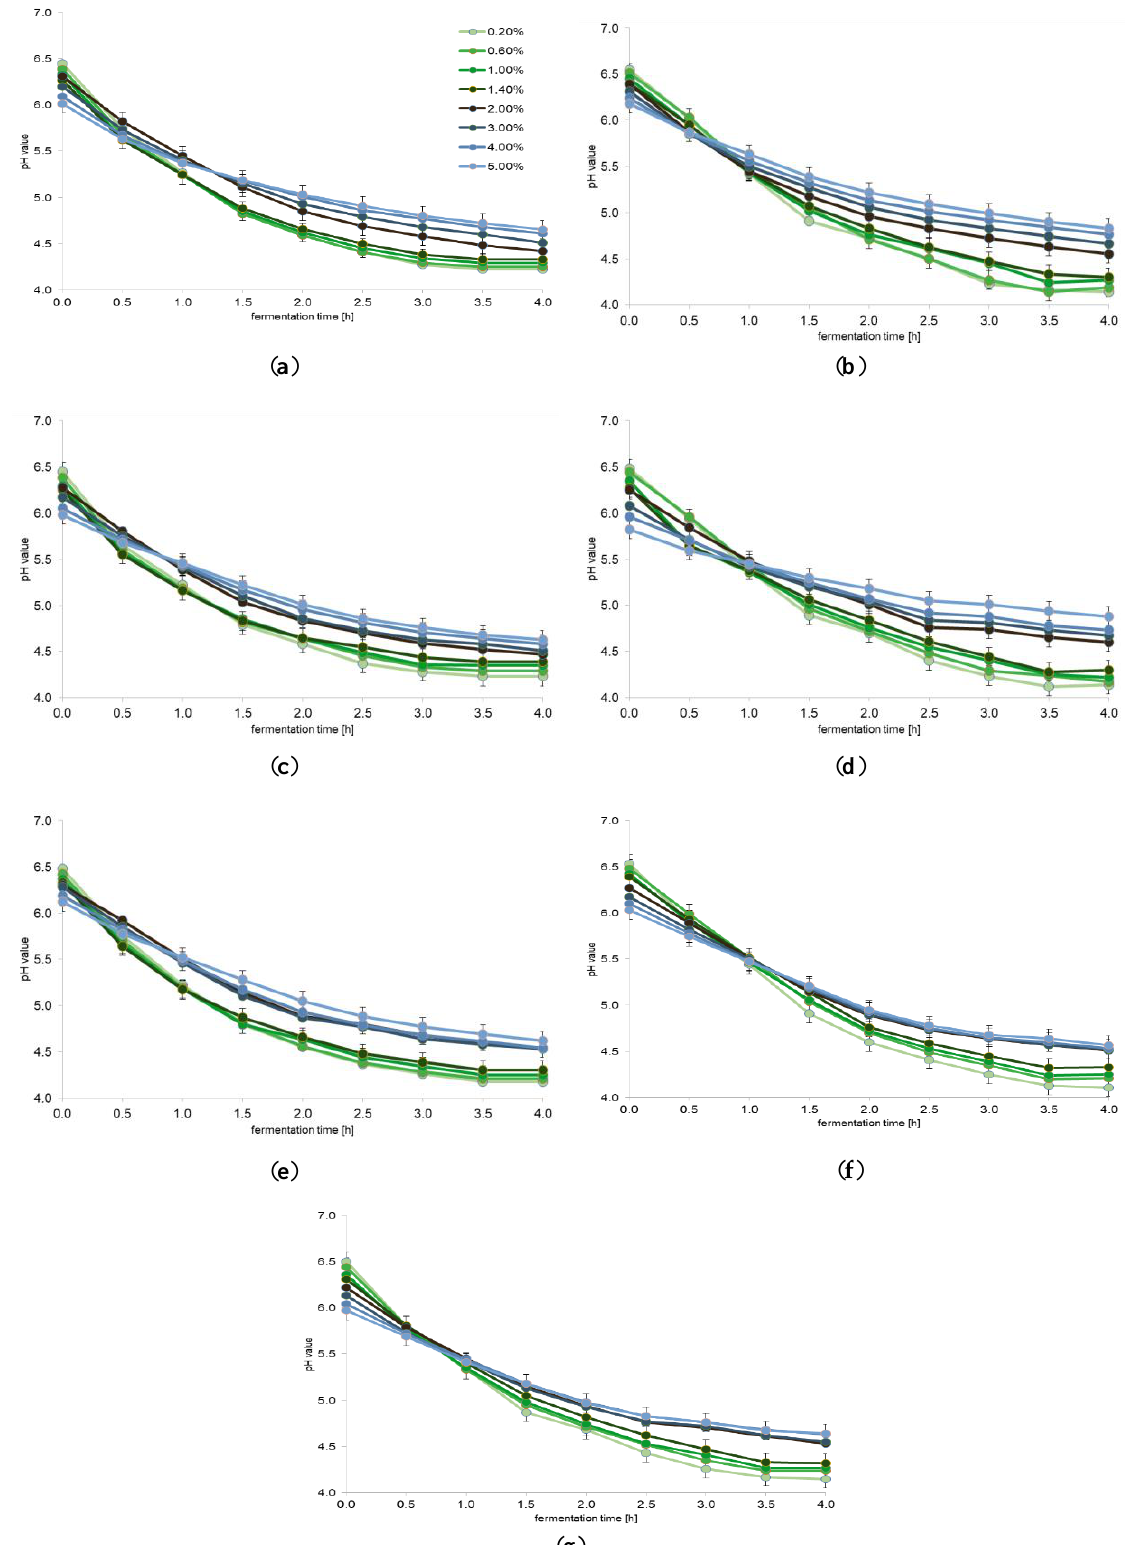
Figure 1. The effect of plant extracts on lactic acid fermentation (average values and standard deviations of three replicates): ( a ) valerian ( Valeriana officinalis L.); ( b ) sage ( Salvia officinalis L.); ( c ) chamomile ( Matricaria chamomilla L.); ( d ) cistus ( Cistus L.); ( e ) linden blossom ( Tilia L.); ( f ) ribwort plantain ( Plantago lanceolata L.); and ( g ) marshmallow ( Althaea L.).